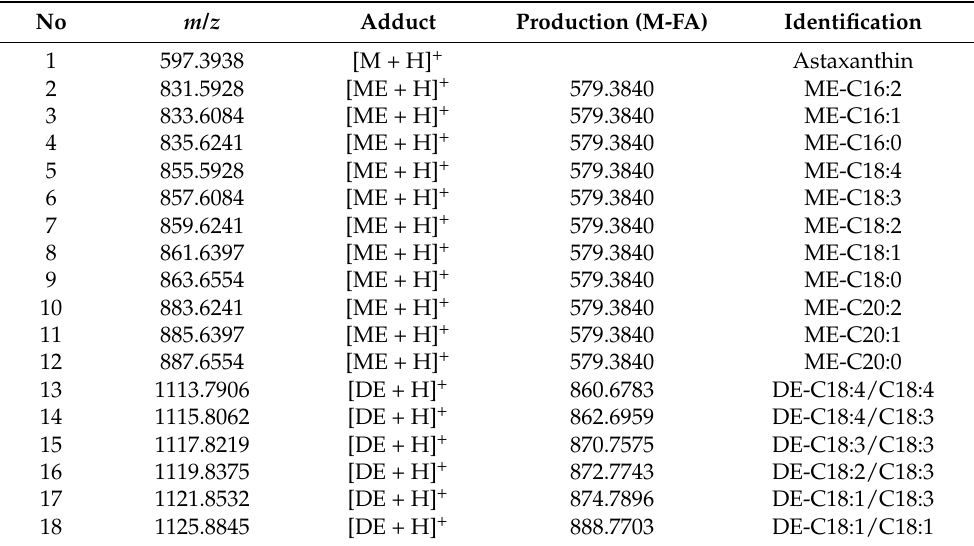
Table 1. Mass spectrometry data of astaxanthin and individual esterified astaxanthins in the